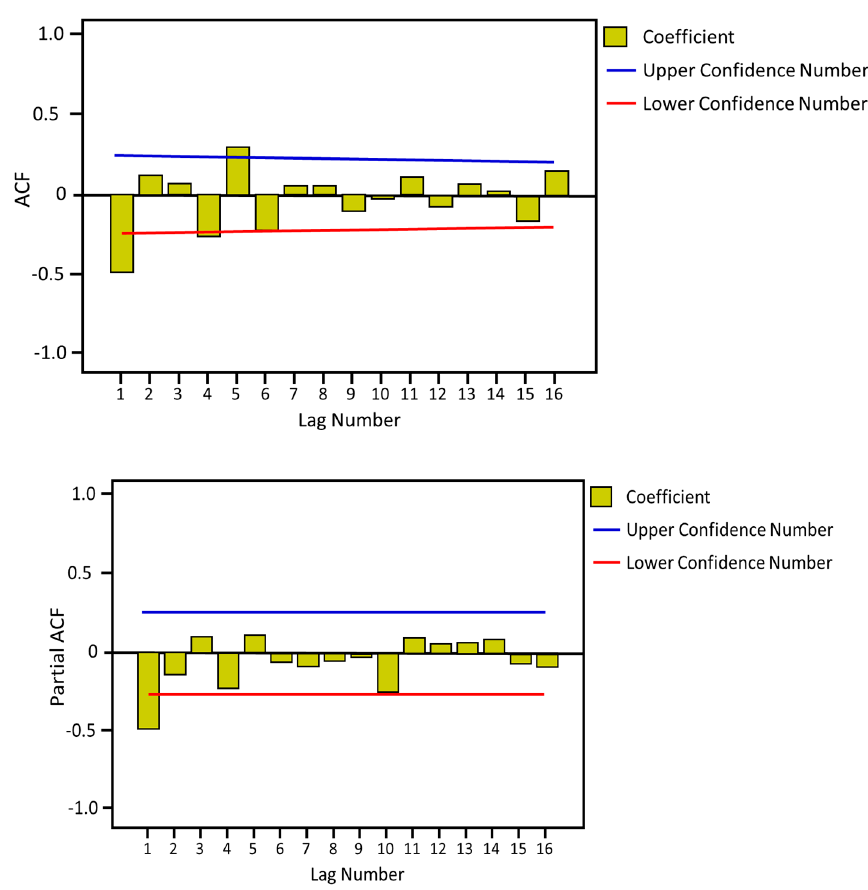
Figure 2. ACF and PACF plots for generation of organic waste.